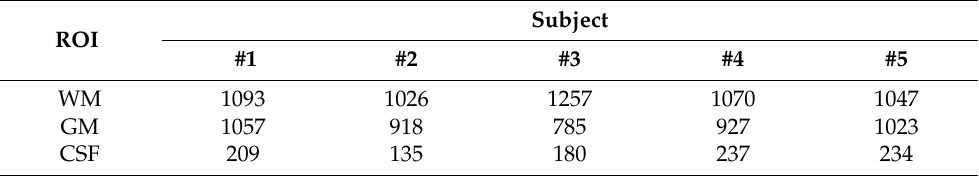
Table 2. Numbers of pixels in the WM, GM, and CSF ROI of the five human brains. The reconstructed conductivity values in these ROIs were compared based on the five image reconstruction methods and also with existing literature